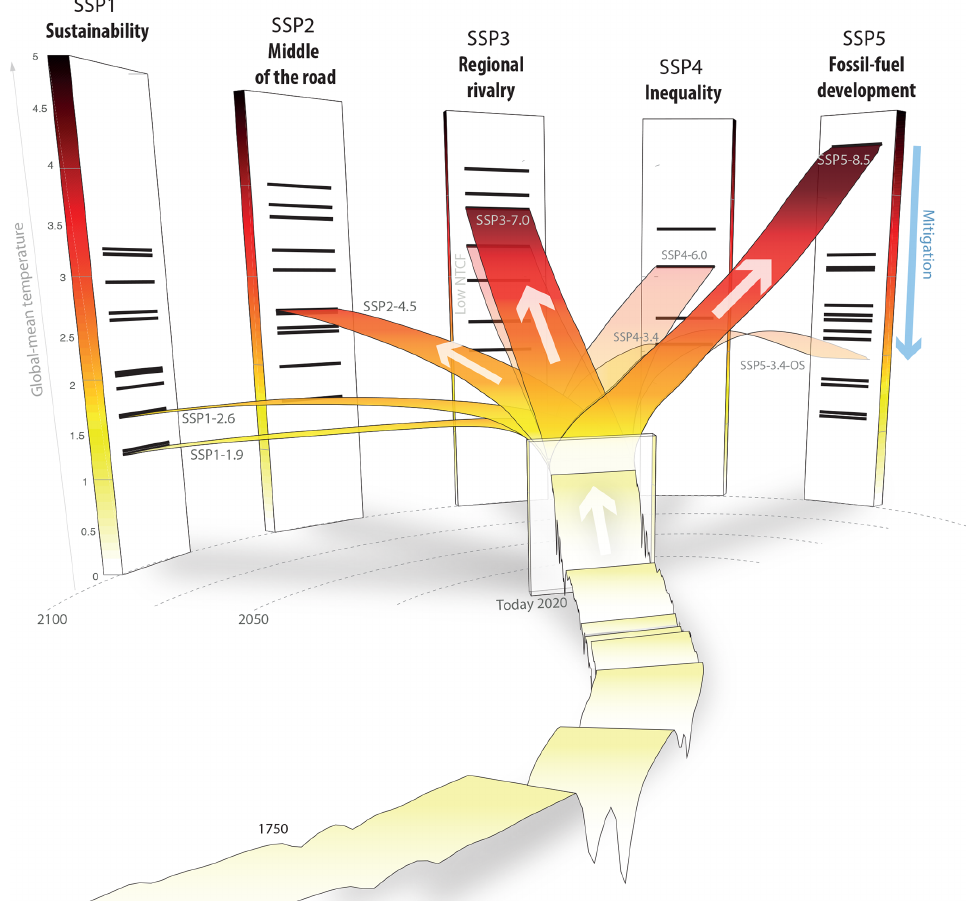
Figure 1. The SSP scenarios and their five socio-economic SSP families. Shown are illustrative temperature levels relative to pre-industrial levels with historical temperatures (front band), current (2020) temperatures (small block in middle), and the branching of the respective scenarios over the 21st century along the five different socio-economic families. The small black horizontal bars on the 2100 pillars for each SSP indicate illustrative temperature levels (obtained by the MAGICC7.0 default setting used to produce the GHG concentrations) for the range of SSP scenarios that were available from the IAM community at the time of creating the benchmark SSP scenarios. The more opaque bands over the 21st century indicate the five SSP scenarios SSP1-1.9, SSP1-2.6, SSP2-4.5, SSP3-7.0, and SSP5-8.5 that are used as priority scenarios in IPCC. The more transparent bands indicate the remaining “Tier 2” SSP scenarios, namely SSP3-7.0-LowNTCF (used in AerChemMIP), SSP4-3.4, SSP4-6.0, and SSP5-3.4-OS. Also shown is a blue indicative bar on the right side, indicating the effect of mitigation action, which reduces temperature levels in 2100 and throughout the 21st century – depending on the respective reference scenario and level of